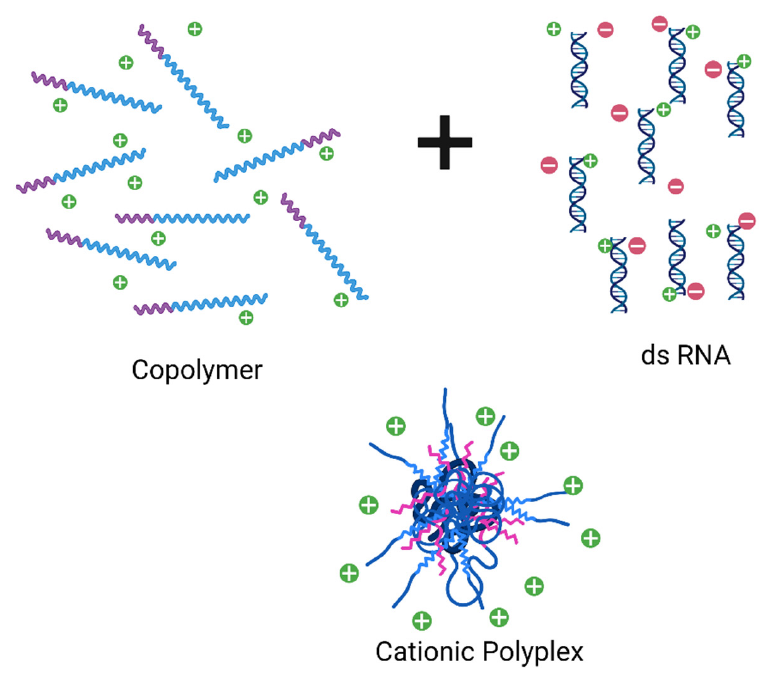
Figure 3. Schematic illustration of self-assembly reaction between cationic copolymer and dsRNA (double-stranded RNA) to prepare a cationic polyplex system as pesticide reservoir pH-sensitive. RNAi-based technologies have designed for the introduction of dsRNA in insects’ gene expression of Spodoptera frugiperda . A biomimetic cationic polymer like pGMPA